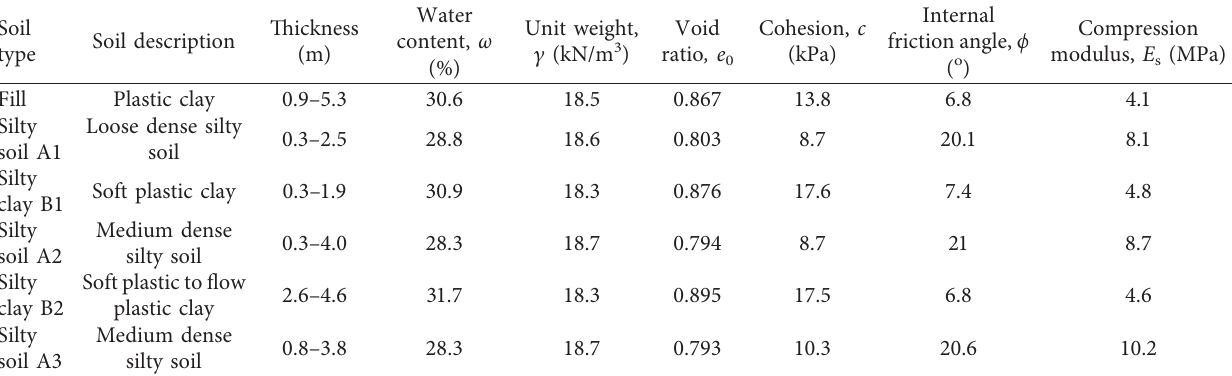
Table 1: Soil parameter.